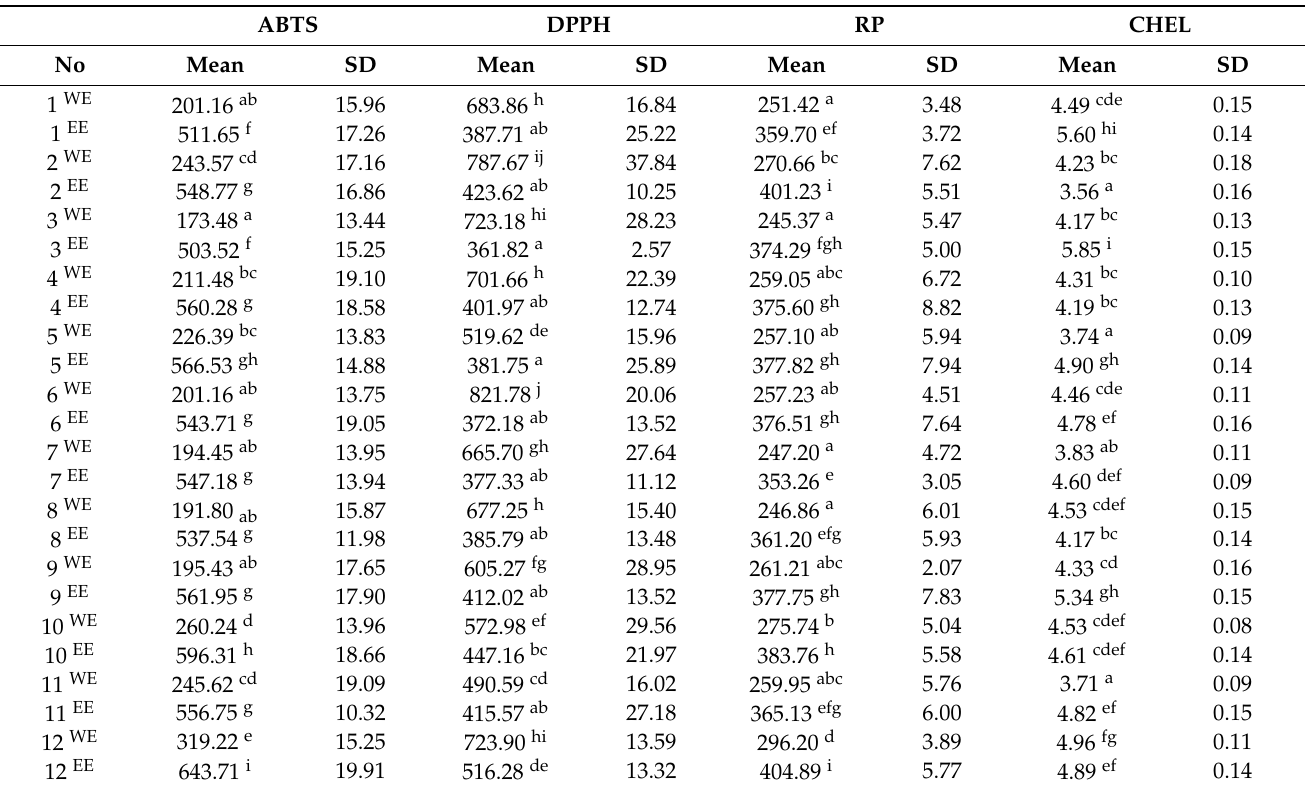
Table 2. Antioxidant activity parameters of water (WE) and ethanol (EE) leaf extracts. ABTS—ABTS •